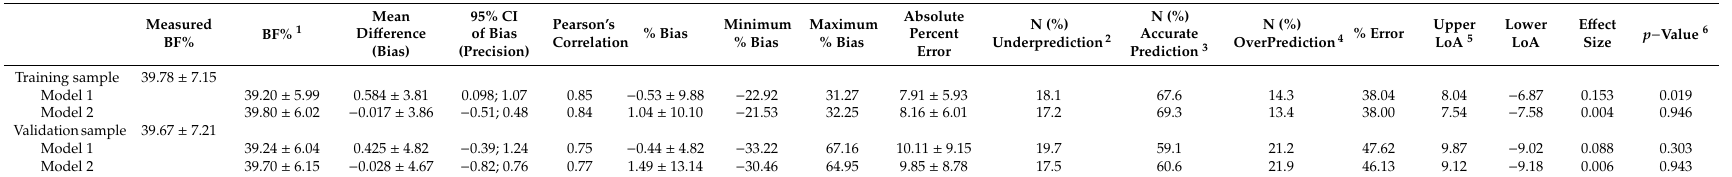
Table 4. Agreement analysis in training ( n = 238) and validation ( n = 137)